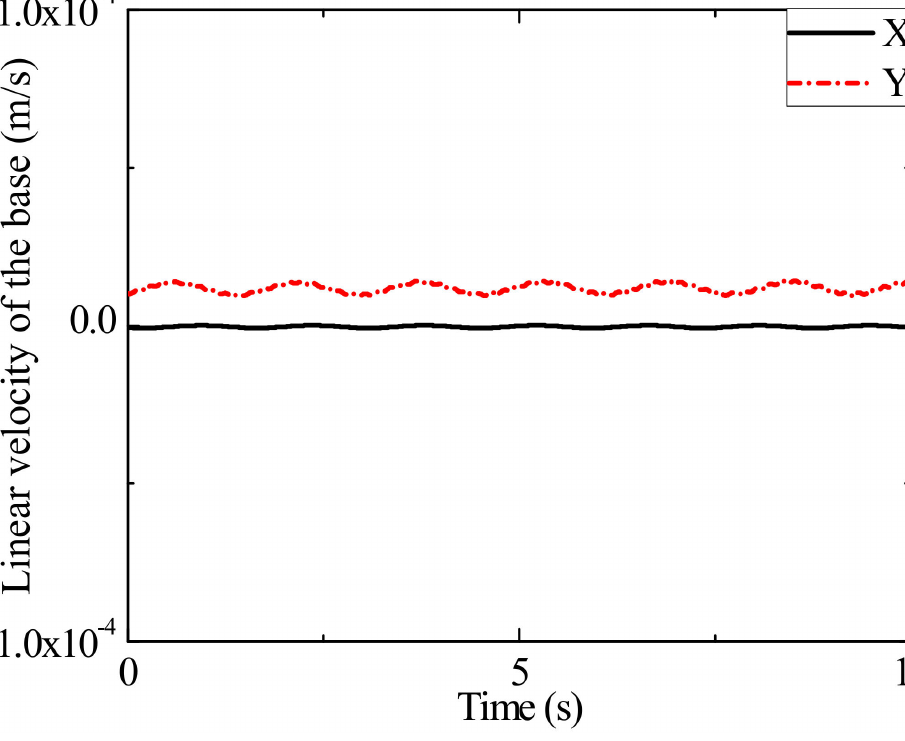
Figure 19. Linear velocity of the base in the trajectory tracking